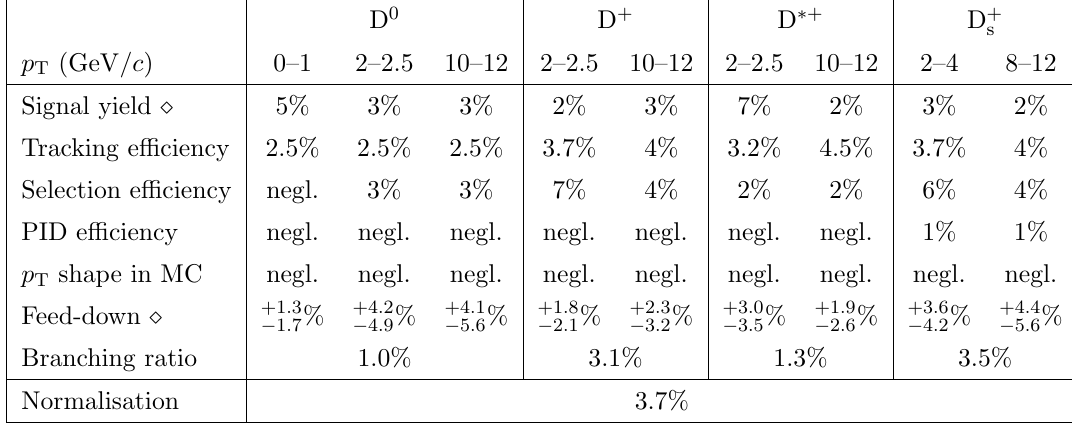
production cross s